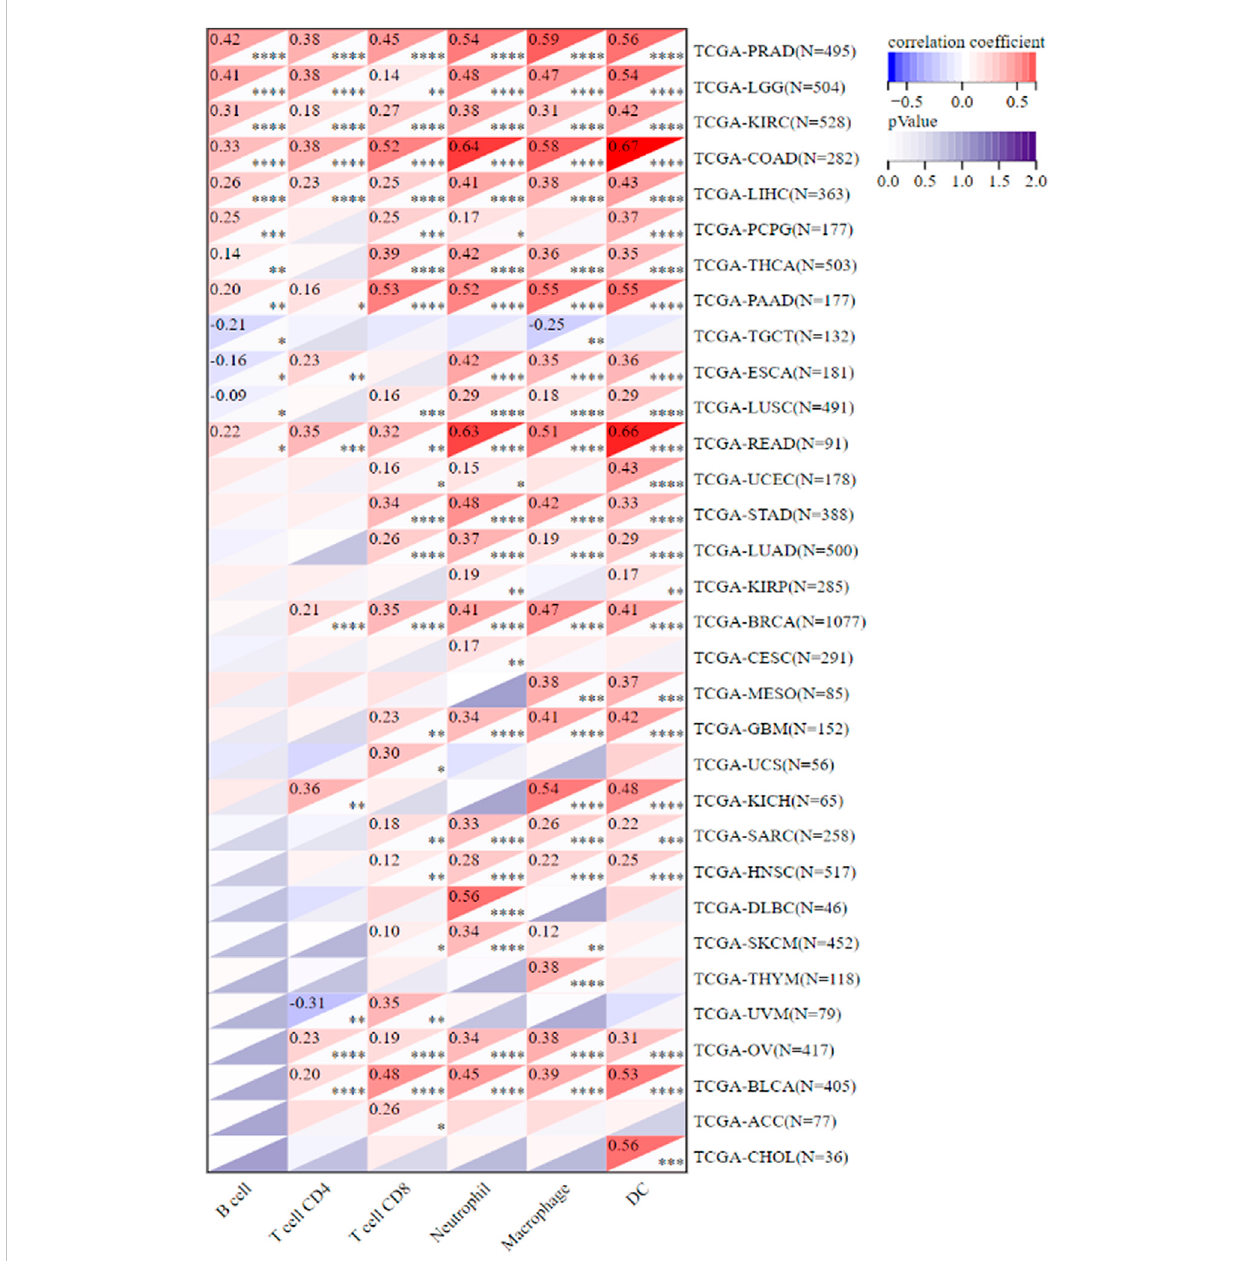
FIGURE 6 IKBIP expression was linked with immune in fi ltration. IKBIP expression had a high connection with immune cell in fi ltration levels in the TIMER